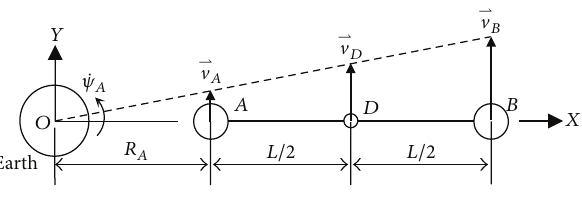
Figure 3: Initial configuration for free